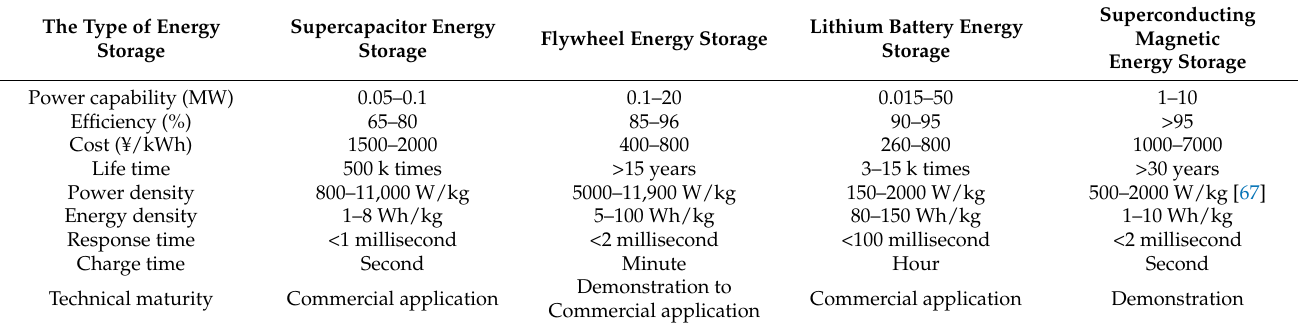
Table 6. Summary of technical characteristic of typical energy storage